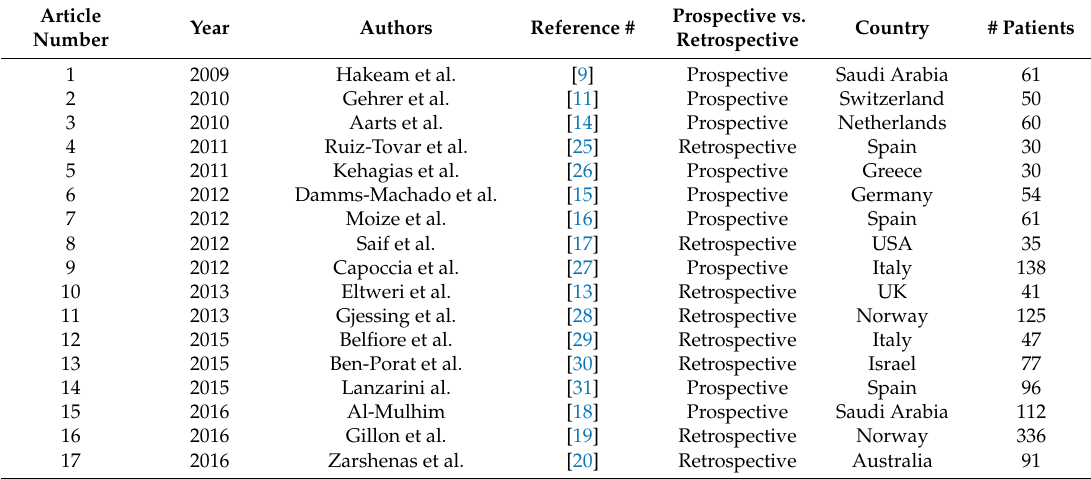
Table 1. Articles reviewed.